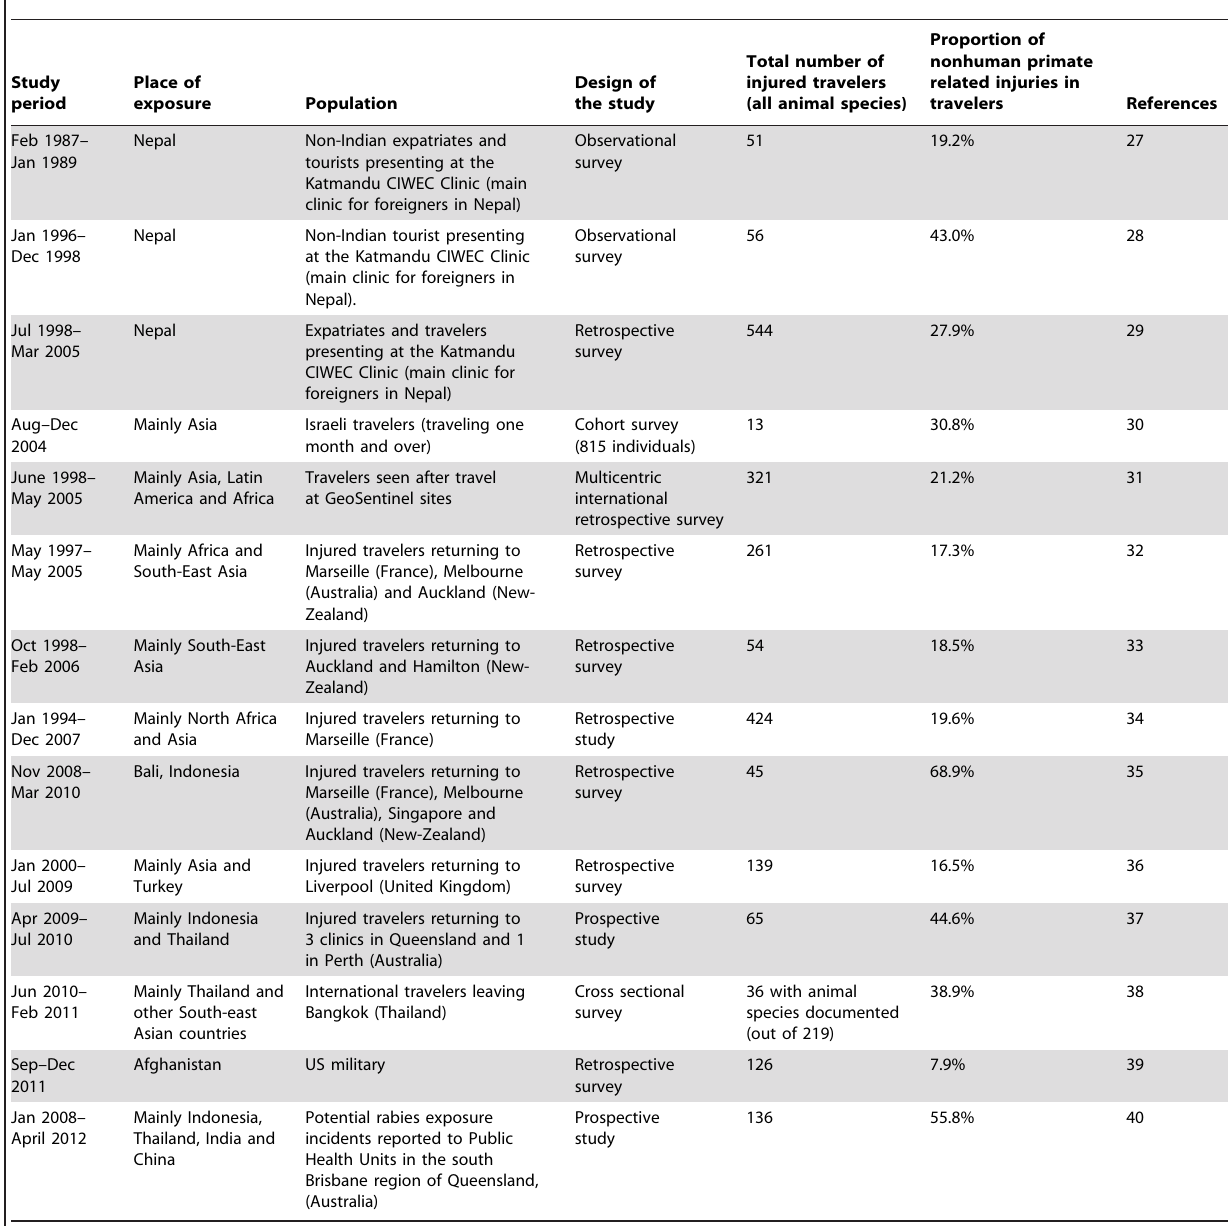
Table 3. Proportion of injuries caused by nonhuman primates among international travelers injured by potentially rabid animals.